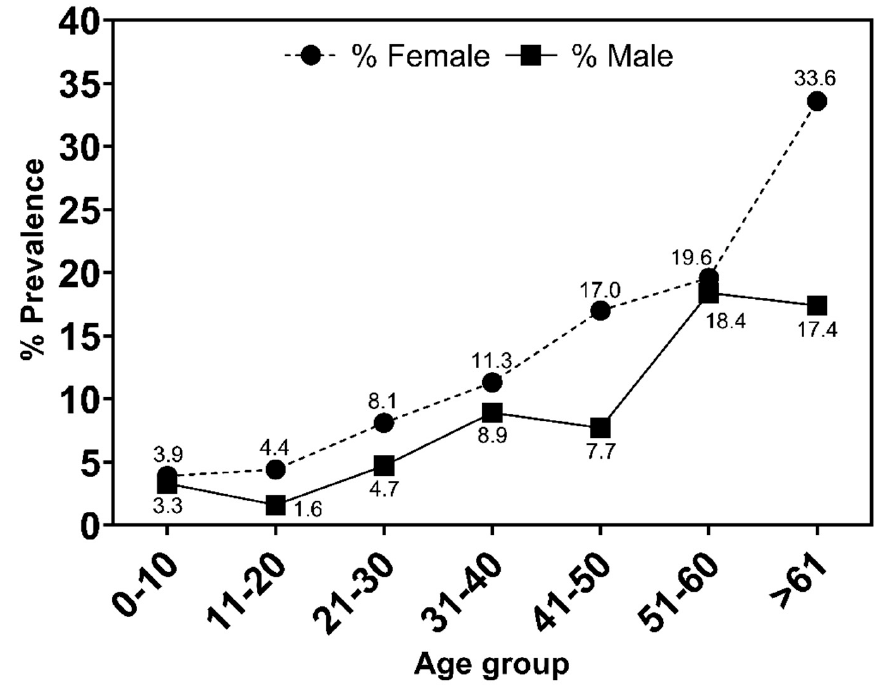
Figure 3. Prevalence of HTLV ‐ 1/2 infection by age and sex.